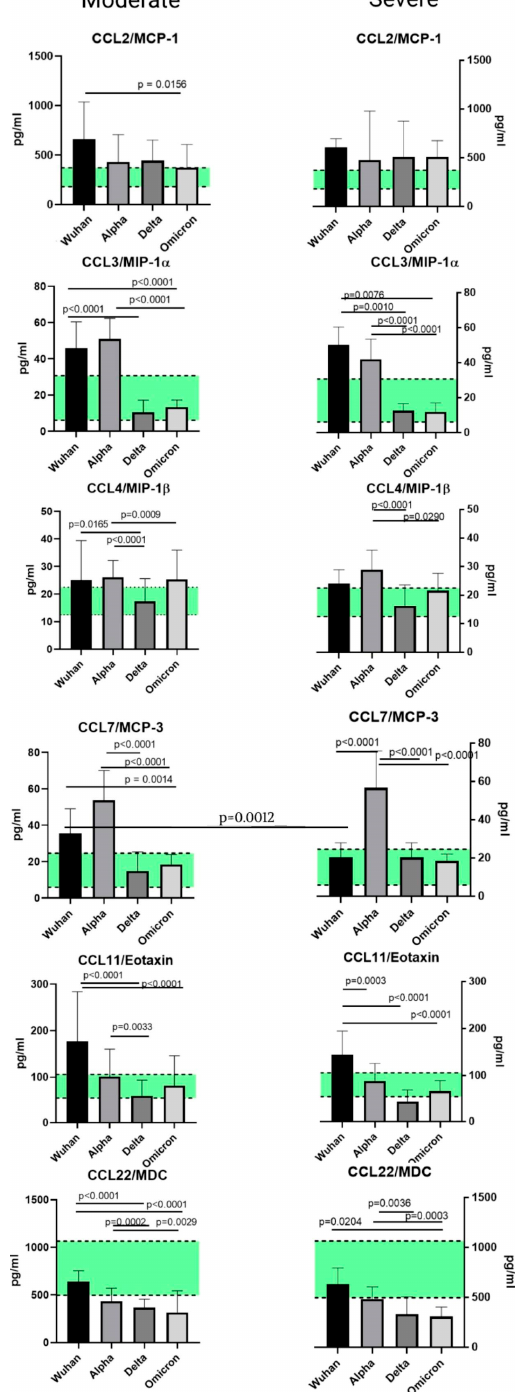
Figure 5. A comparison of the concentrations of C-C chemokines in patients with Wuhan, Alpha, Delta, and Omicron strains, depending on severity. The concentrations are presented in pg/mL (me- dian and interquartile range). The green stripe represents Q25–Q75 of the chemokine concentrations in the samples from healthy